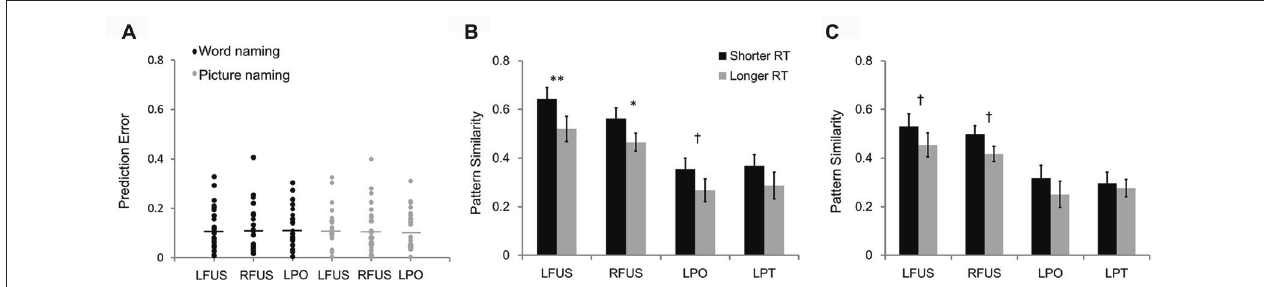
FIGURE 7 | The scatter plot (A) shows prediction errors for leave-one-out cross-validation. The two bar graphs show differences in pattern similarity between artificial language words with longer RT and those with shorter RT in word naming (B) and picture naming tasks (C) . LFUS, left fusiform; RFUS, right fusiform; LPO,